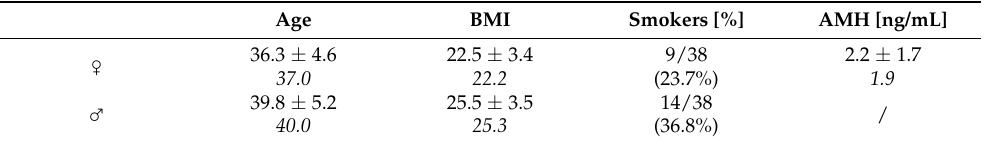
Table 8. Demographic characteristics of the couples of the subpopulation studied and AMH value on the day of oocyte pick-up. Continuous variables are presented as mean ± SD and median (in italics); categorical variables are presented as counts and percentages.